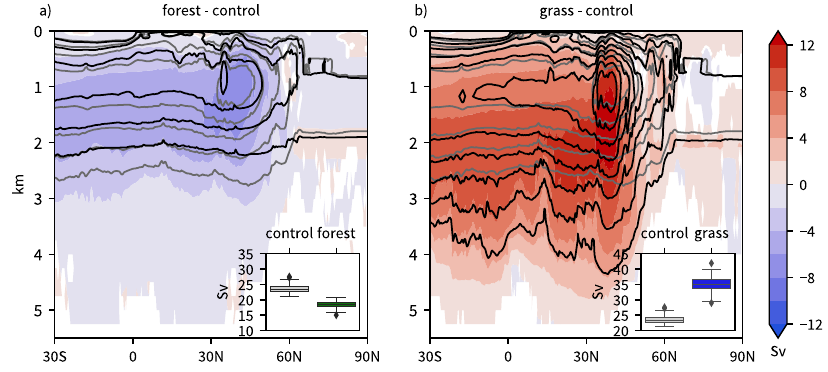
Fig. 3 | Slowdown and acceleration of the Atlantic meridional overturning circulation. Shown is the annual mean meridional mass stream function in the Atlantic, i.e., the AMOC (contours, in Sv, only values above 4Sv shown with a 4Sv interval) for a forest (black) and control (gray) and b grass (black) and control